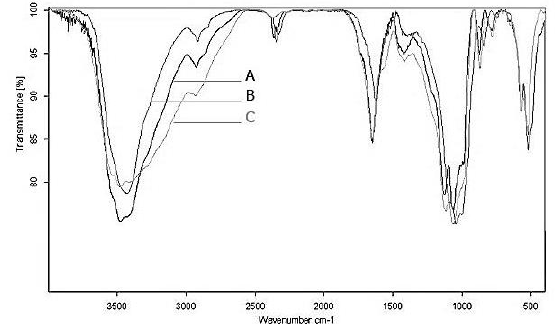
Figure 1. The effect of different loading rates of surfactant on the sorption Contact time = 24 hours; Bromocresol green (BCG) concentration = 100 mg/l; Adsorbent dosage = 1 g/l; pH = 7 FTIR analysis revealed the presence of different functional groups in the molecule. In figures 1-3, the spectrum peak at the range of 3400-3500 cm −1 showed the presence of N-H bands in the molecule. The weak band noticed at 2500-3300 cm −1 indicated the presence of carboxylic acids and their derivatives. The spectrum peak at 1630-1695 cm −1 was an indication of the presence of an amide group.